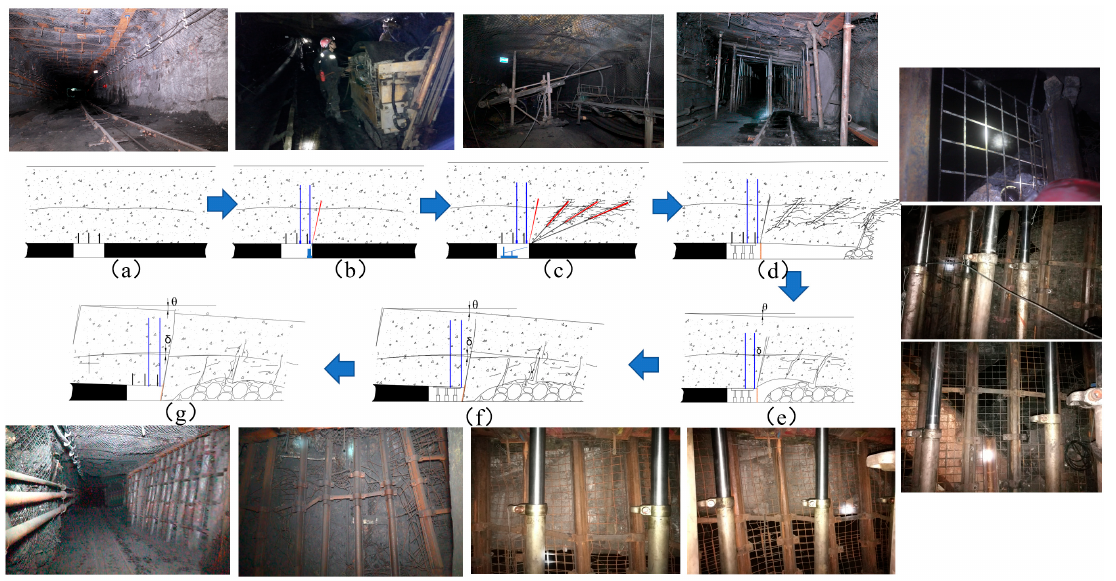
Figure 9. Non-pillar mining process ( a ) Applying constant resistance and large deformation anchor cable (CRLDA) ( b ) Roof pre-splitting and slitting (zone I) ( c ) Roof deep hole blasting (zone II zone III) ( d ) Hydraulic supports in the roadway ( e ) After the working face is mined, the roof of the goaf gradually collapses ( f ) The roof of the goaf completely collapses ( g ) The roadway is stable, and the hydraulic supports are withdrawn.